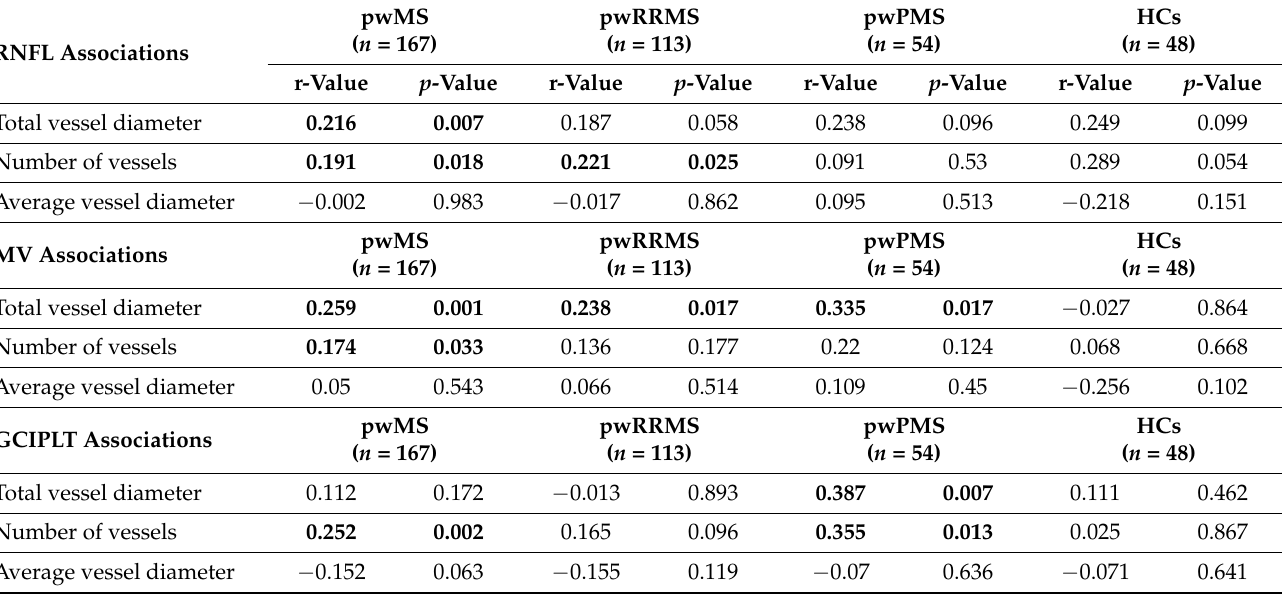
Table 5. Relationship between retinal vasculature and retinal layer thickness in pwMS and HCs at the follow-up visit.